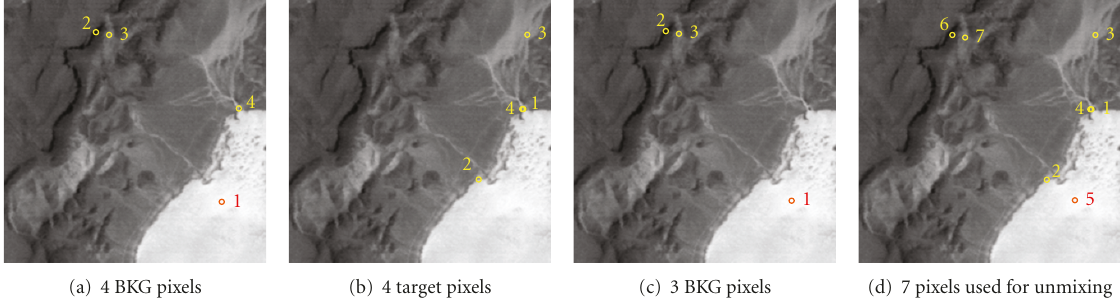
Figure 33: UFCLS-generated BKG and target pixels (a) 4 BKG pixels in original data; (b) 4 target pixels in sphered data; (c) 3 BKG pixels not identified as target pixels; (d) 7 pixels obtained by combining the pixels in